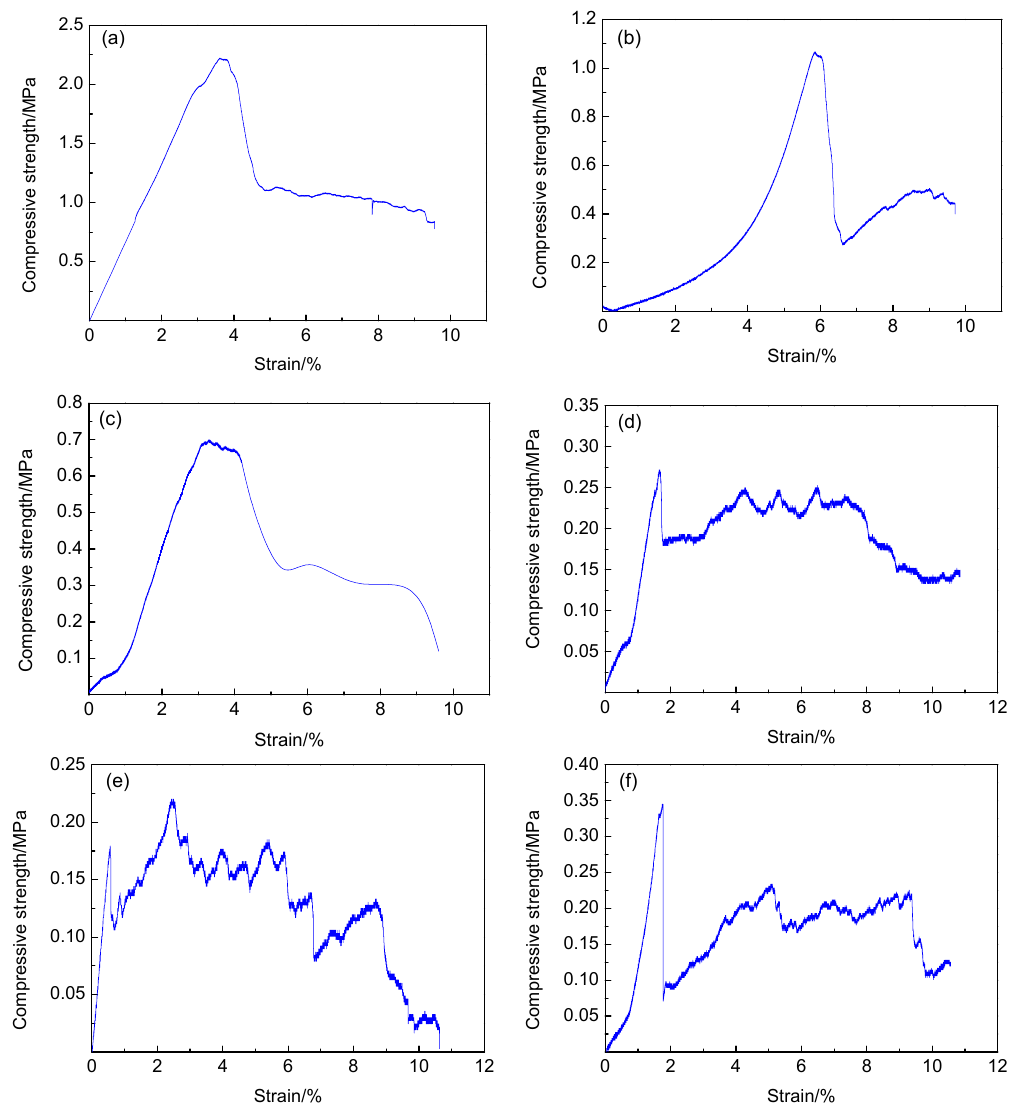
Figure 4. Stress ‐ strain curves of samples under uniaxial compression, ( a ) stress ‐ strain curve of Figure 4. Stress-strain curves of samples under uniaxial compression, ( a ) stress-strain curve of sample sample B3, ( b ) stress ‐ strain curve of sample B1, ( c ) stress ‐ strain curve of sample D1, ( d ) stress ‐ strain B3, ( b ) stress-strain curve of sample B1, ( c ) stress-strain curve of sample D1, ( d ) stress-strain curve of curve of sample A2, ( e ) stress ‐ strain curve of sample A3 and ( f ) stress ‐ strain curve of sample A1. sample A2, ( e ) stress-strain curve of sample A3 and ( f ) stress-strain curve of sample